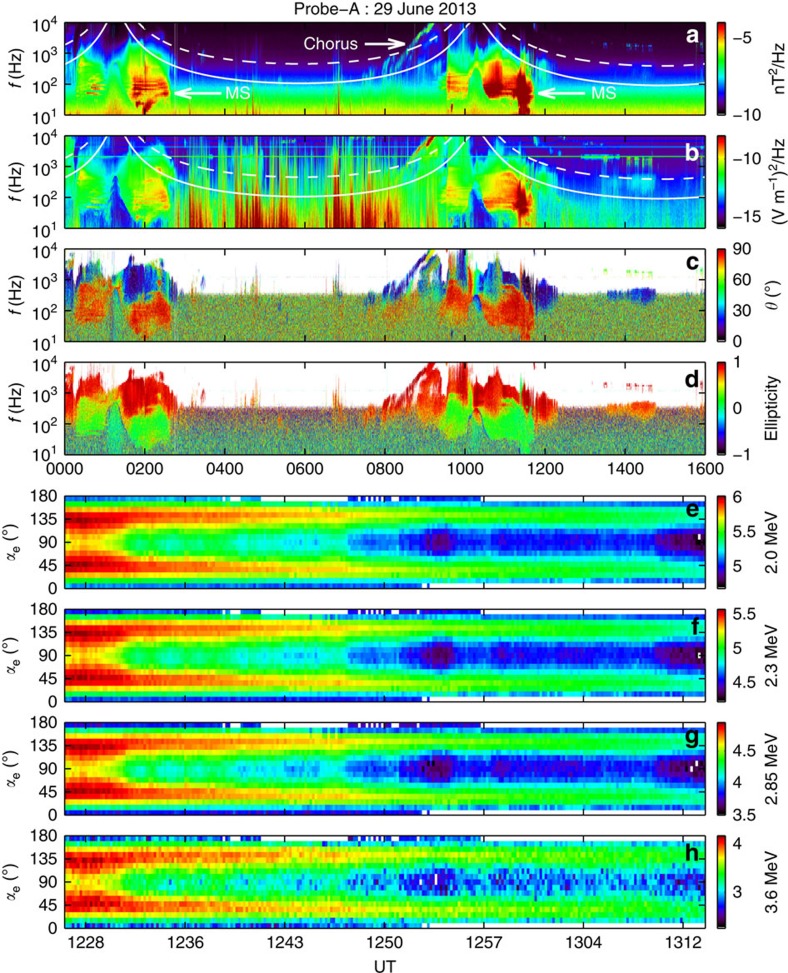
Formation of butterfly distribution of relativistic electrons.Data from the EMFISIS instrument for magnetic and electric spectral intensity (in unit of log10) of chorus and MS waves (a,b), wave normal angle (c), the angle between Earth's magnetic field and the normal to the plane of the wave, and wave ellipticity (d), the degree of elliptical polarization. Chorus wave occurs above 0.1fce (the white dashed line). MS wave occur as a series of narrow tones, spaced at multiples of the proton gyrofrequency fcp up to flhr (the white solid line). (c,d) The observed MS or chorus wave has a high (θ≈90°) or low (θ≈0°) normal angle and a high (ellipticity≈0) or low (ellipticity≈1) degree of elliptical polarization. (e–h) Pitch angle distribution for different indicated energies (2–3.6 MeV) over ∼40 min duration from the REPT instrument. Fluxes (in the same unit as that in Fig. 1) of relativistic electrons have minima around pitch angle 90°, and peaks around the pitch angle range of 30°–60° or 120°–150°.